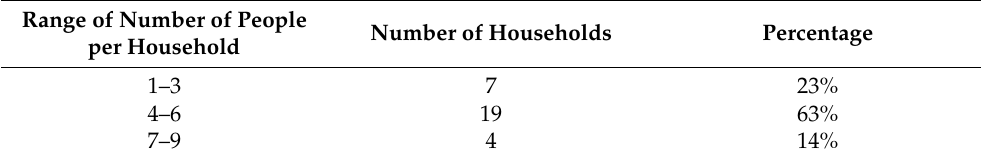
Table 1. Number of people per household. Range of Number of